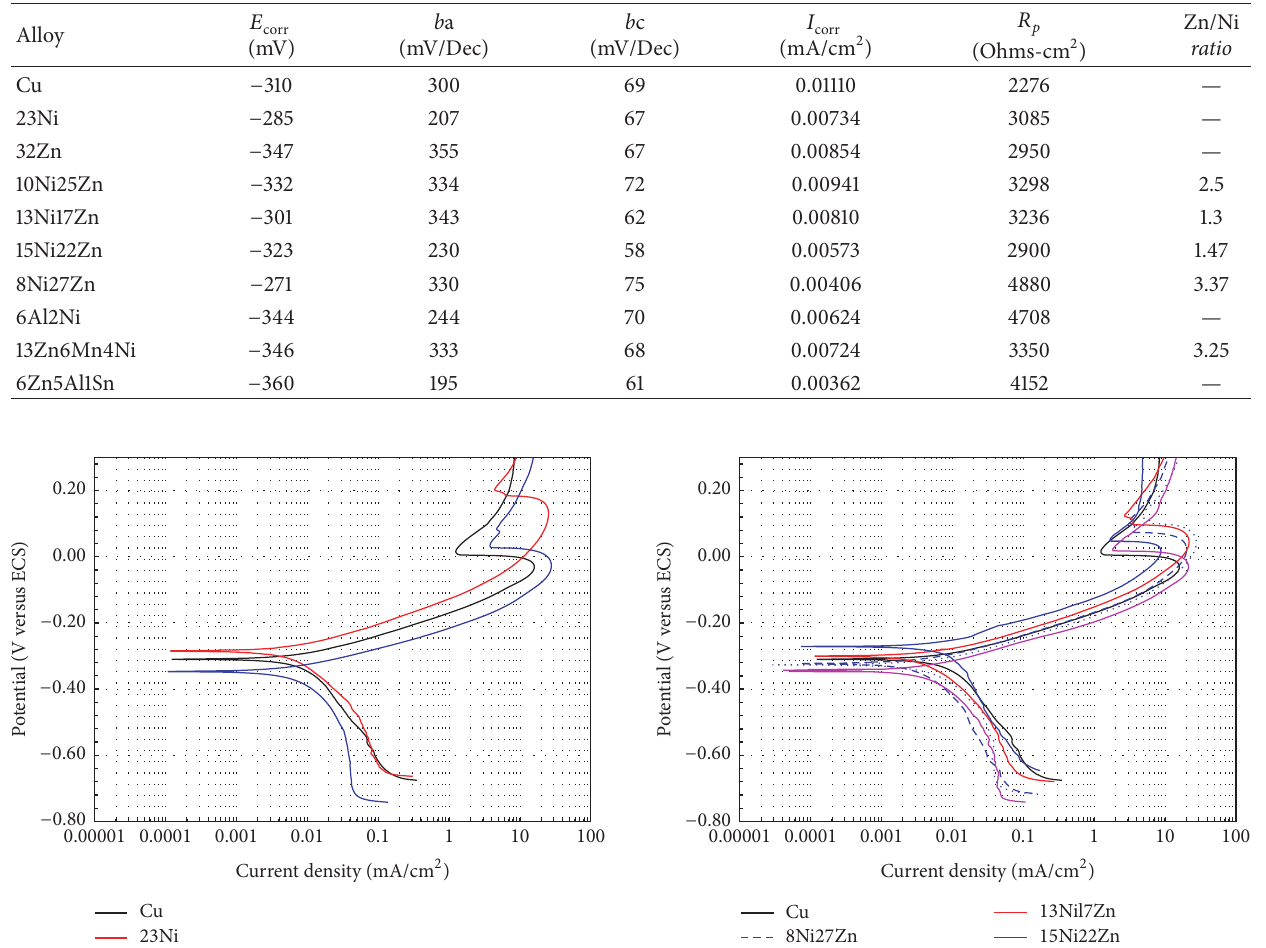
Table 3: Electrochemical parameters of the Cu-based coins evaluated in artificial sweat at 37 ∘ C.